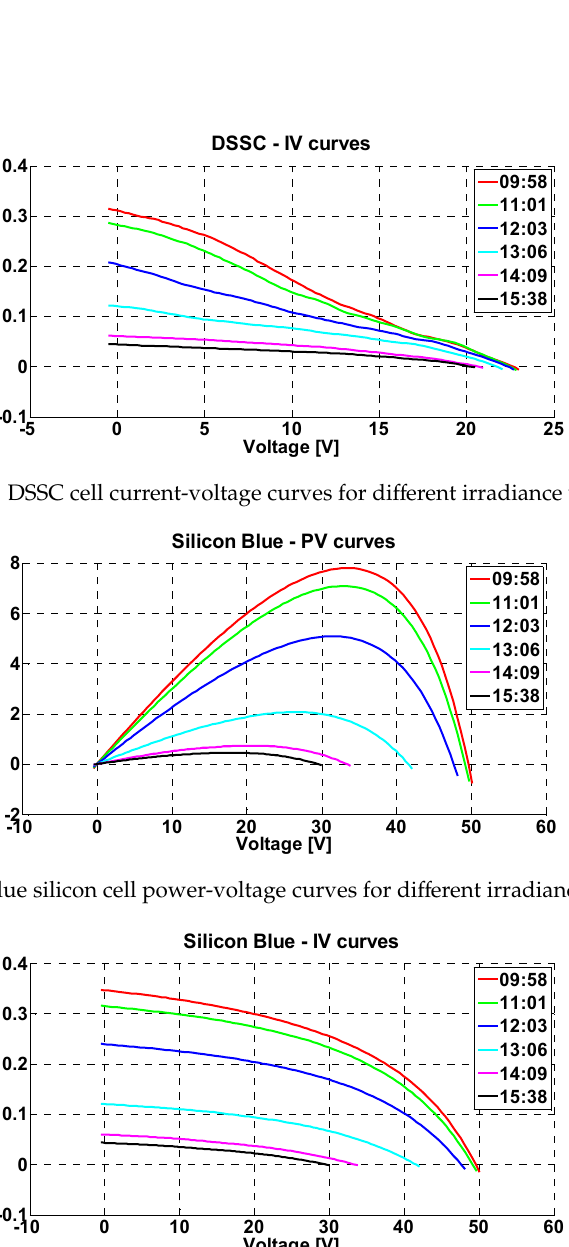
Figure 15. DSSC cell power-voltage curves for different irradiance values.